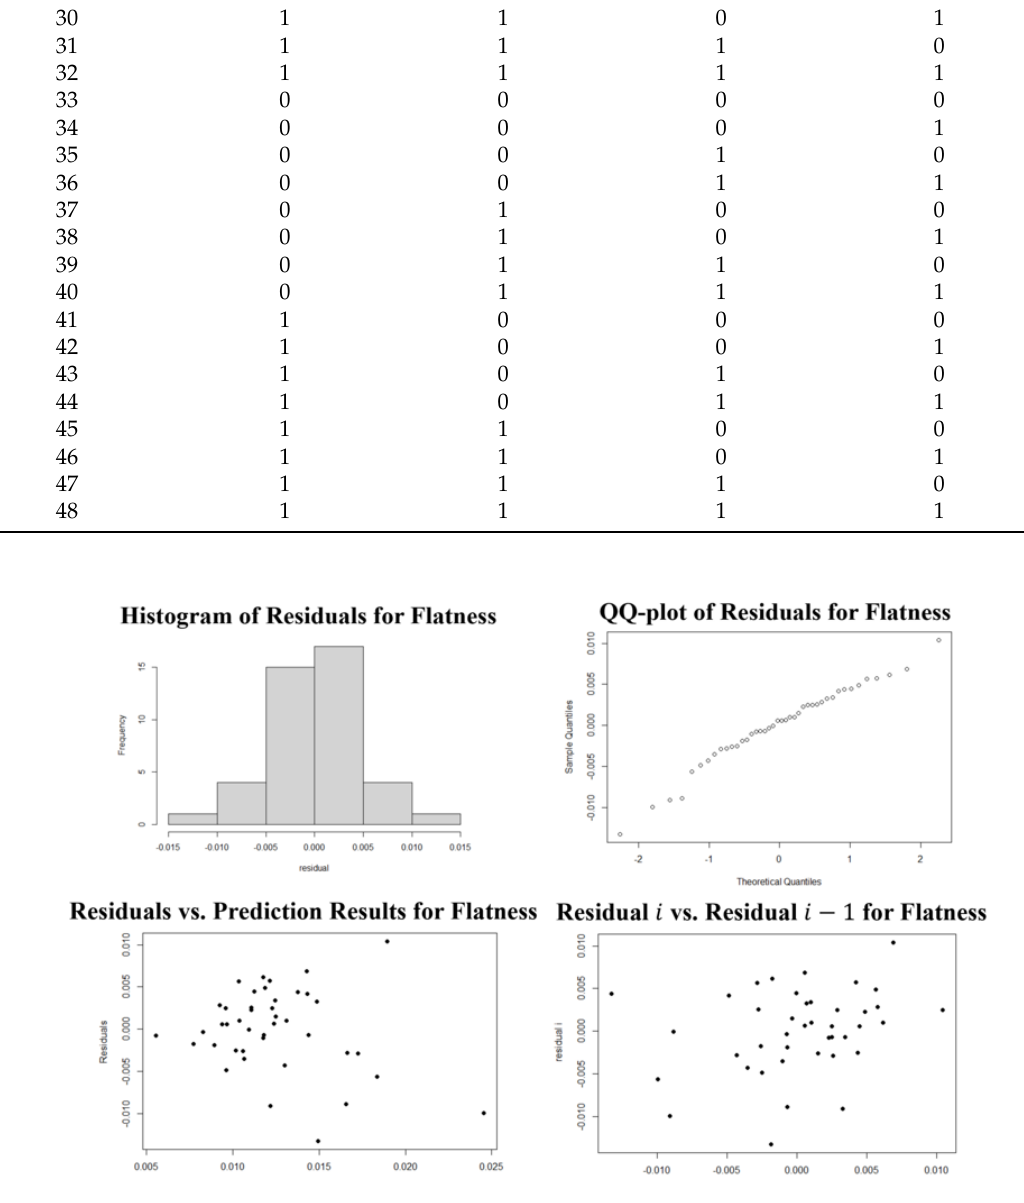
Figure A1. Residual Plot and Assumption Check for the Proposed MOSS in Case